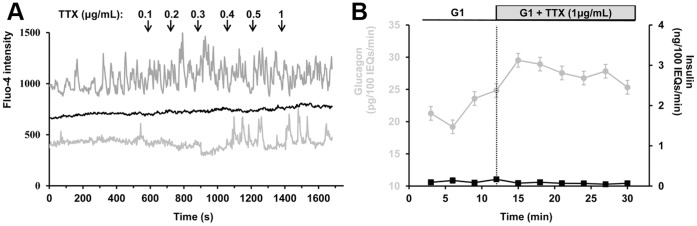
Effects of voltage-gated sodium channel inhibition on islet [Ca2+]i and hormone secretion.Gray and black traces represent α- and β-cells, respectively. A, representative intracellular calcium responses to tetrodotoxin (TTX) in an intact mouse islet perifused at 1 mM glucose. Increasing concentrations of TTX were perifused at times indicated by the arrows. TTX stimulates calcium activity in α-cells while having no noticeable effects on β-cells. Fluo-4 intensity is expressed in arbitrary units. The figure is representative of 18 α-cells analyzed from 6 islets harvested from 3 mice. B, effects of TTX on glucagon and insulin secretion from intact perifused islets. Isolated islets were exposed to 1 mM glucose for 30 minutes (from −30 to 0 min). Glucagon and insulin responses were measured for 9 minutes at 1 mM glucose (G1), and then TTX was perifused. Experiment was repeated 6 times, 900 islets from 12 mice were used. Error bars represent the standard error of the mean.